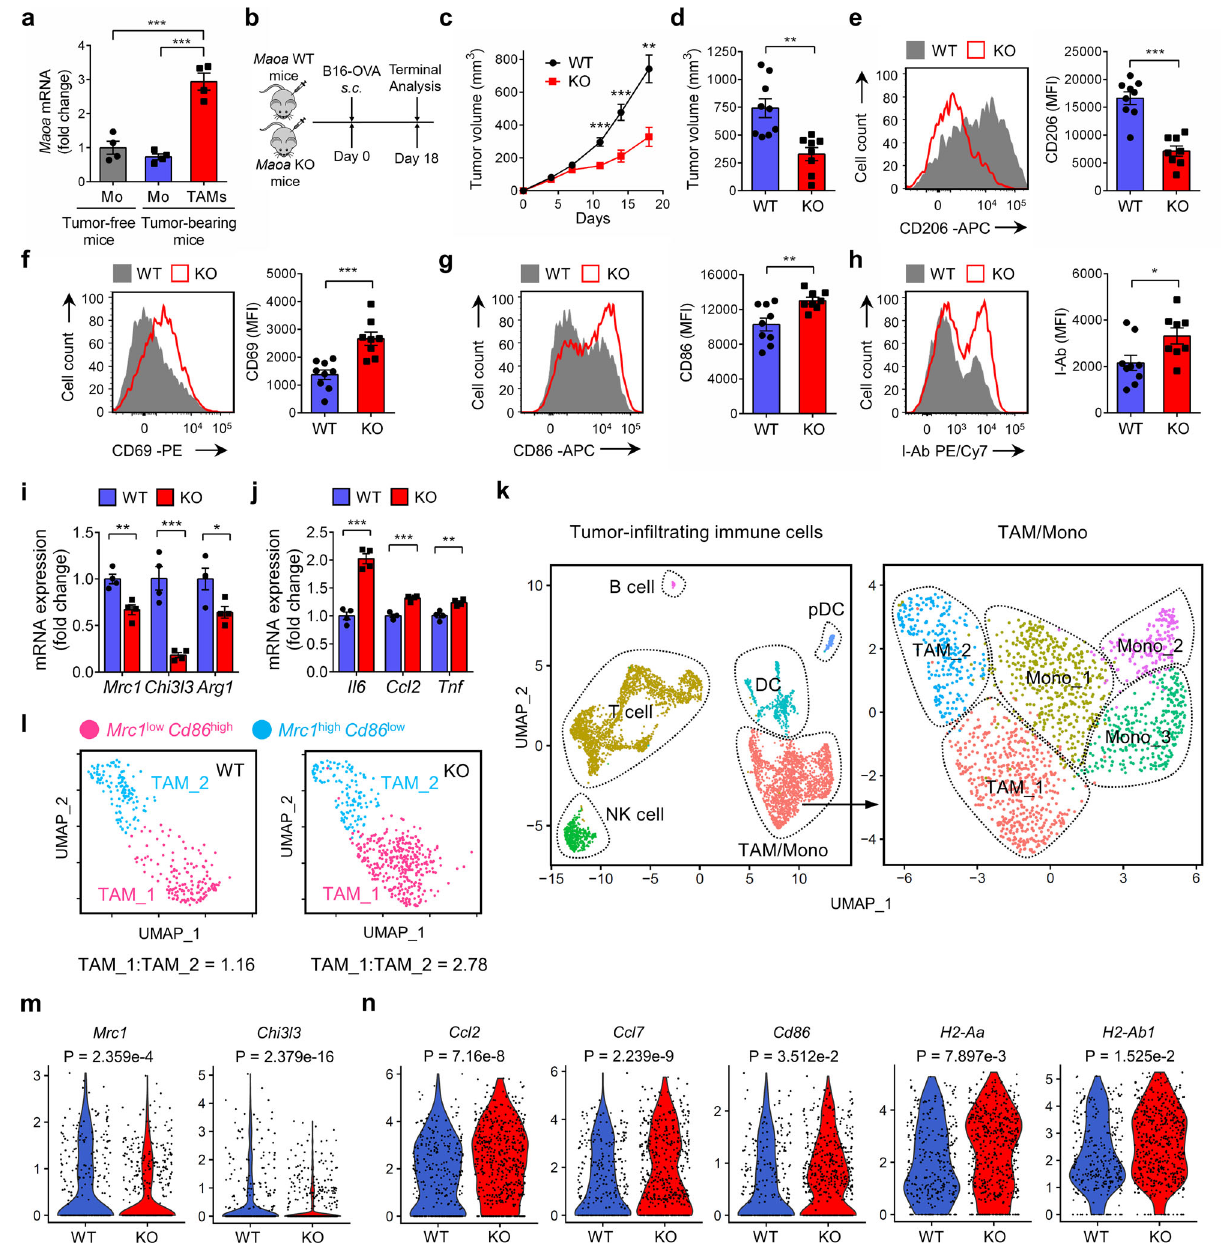
Fig. 1 MAO-A-de fi cient mice show reduced tumor growth associated with altered TAM polarization. a QPCR analyses of Maoa mRNA expression in TAMs isolated from wild-type mice-bearing B16-OVA tumors. Monocytes (Mo) were isolated from peripheral blood of tumor-free and tumor-bearing mice (*** p < 0.001). N = 4. b – j Studying B16-OVA tumor growth in Maoa WT and Maoa KO mice. b Experimental design. c Tumor growth (** p = 0.0038, *** p < 0.001). d Tumor volume at day 18 (** p = 0.0038). e – h FACS analyses of CD206 ( e ) (*** p < 0.001), CD69 ( f ) (*** p < 0.001), CD86 ( g ) (** p = 0.0064) and I-Ab ( h ) (* p = 0.0275) expression on TAMs at day 18. WT, n = 9; KO, n = 8. MFI mean fl uorescence intensity. i , j QPCR analyses of immunosuppressive ( Mrc1 , ** p = 0.0041; Chi3l3 , *** p < 0.001 and Arg1 , * p = 0.0339; i ) and immunostimulatory ( Il6 , *** p < 0.001; Ccl2 , *** p < 0.001 and Tnf , ** p = 0.0036; j ) signature genes mRNA expression in TAMs ( n = 4). k – n scRNAseq analyses of tumor-in fi ltrating immune cells (TIIs) from Maoa WT and Maoa KO mice at day 14 post B16-OVA tumors challenge. k Uniform Manifold Approximation and Projection (UMAP) of single TIIs showing the formation of six cell clusters (TAM/Mono, T cell, NK cell, B cell, DC and pDC) from total CD45.2 + TIIs and fi ve cell clusters (TAM_1, TAM_2, Mono_1, Mono_2 and Mono_3) from the TAM/Mono subpopulation. Each dot represents one single cell and is coloured according to cell types. Mono monocyte, NK natural killer cell, DC dendritic cell, pDC plasmacytoid dendritic cell. l UMAP of the TAM subpopulation, showing the formation of two clusters (TAM_1: Mrc1 low Cd86 high ; and TAM_2: Mrc1 high Cd86 low ). Each dot represents one single cell and is coloured according to cell clusters. Ratios of TAM_1:TAM_2 are presented. m , n Violin plots of immunosuppressive ( Mrc1 and Chi3l3 ; m ) and immunostimulatory ( Ccl2 , Ccl7 , Cd86 , H2-Aa , and H2-Ab1 ; n ) signature genes expression in single TAMs. Each dot represents an individual cell. Representative of 1 ( k – n ), 3 ( a ), and 5 ( b – j ) experiments. Analysed by one-way ANOVA ( a ) or by Student ’ s t test ( c – j ). p values of violin plots are determined by Wilcoxon rank-sum test ( m , n ). Statistics are all two-sided. Source data are provided as a Source Data fi